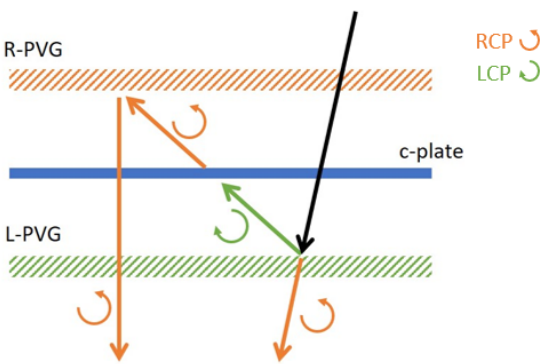
Figure 10. Schematic illustration of a thin-film polarization converter based on two PVGs and a c- plate.